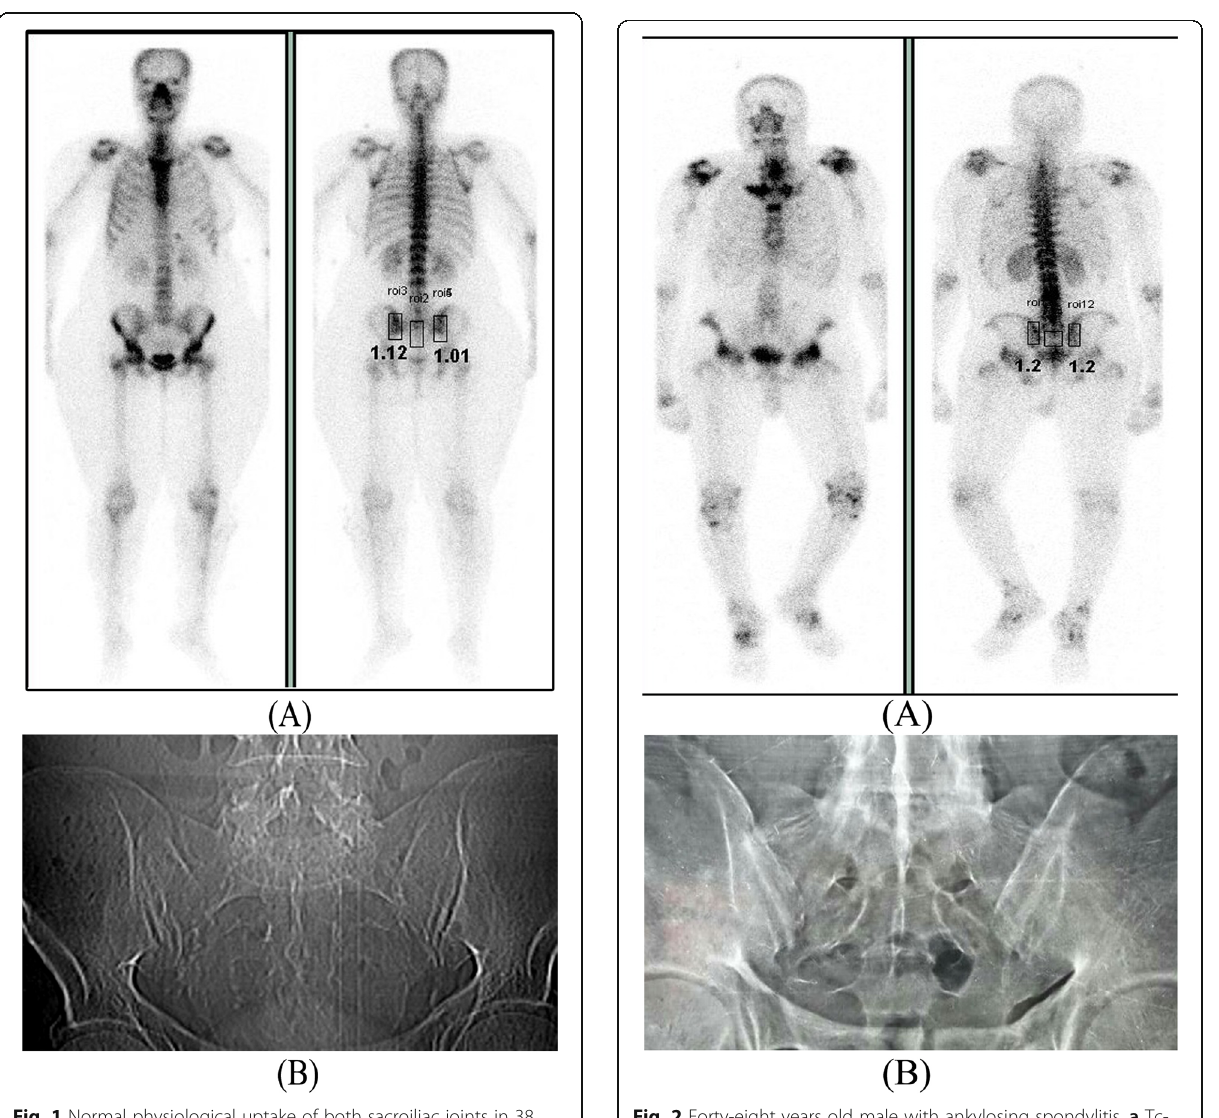
Fig. 2 Forty-eight years old male with ankylosing spondylitis. a Tc- 99 m MDP whole-body bone scintigraphy (anterior and posterior views) shows increased uptake of both sacroiliac joints (right SII = 1.2, left SII = 1.2). b X-ray radiography of sacroiliac joints (AP view) reveals sclerosis, irregularity, and narrowing of both sacroiliac